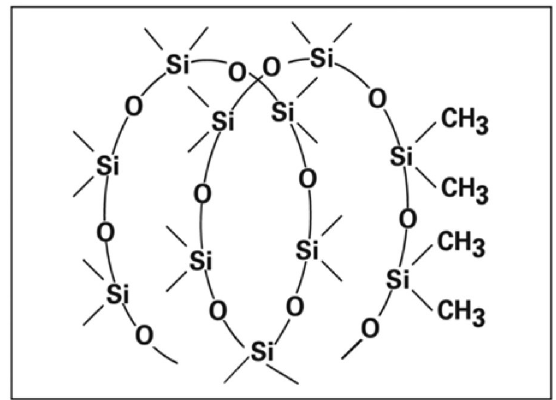
Figure 1. The structure of Dimethyl polysiloxane “Silicon